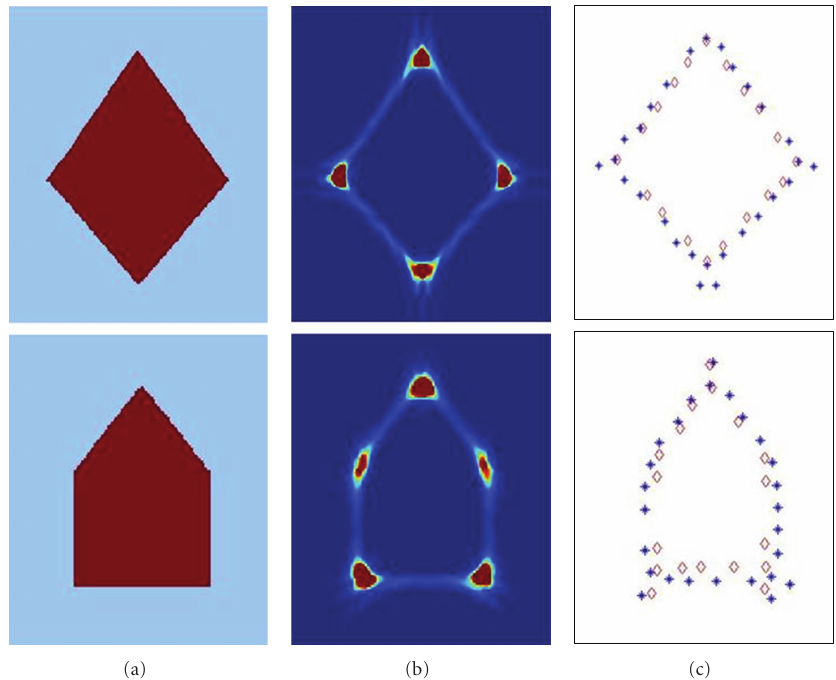
Figure 4: The original (a), SAR-processed (b), and scattering centers (c) images of PEC objects with two di ff erent geometries. Scattering center images are obtained for both Gauss (stars) and LFM (diamond)